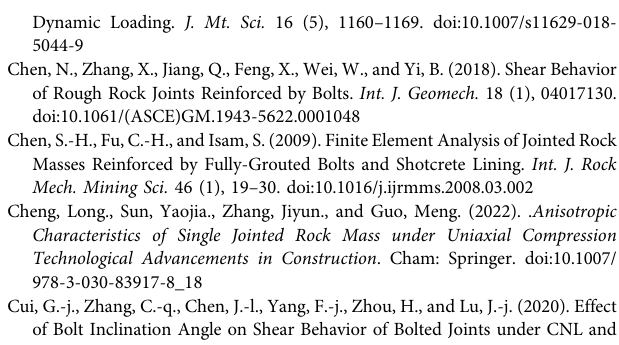
Supplementary Table S1 | Mechanical parameters of the actual rock and mortar Supplementary Table S2 | Mechanical parameters of the prototype rock and simulated bolts Supplementary Table S3 | UCS and the peak strain of jointed and bolted jointed specimens Supplementary Table S4 | Angle of the maximum principle strain direction of jointed and bolted jointed specimens Supplementary Table S5 | Material properties of the specimen used for numerical simulation Supplementary Table S6 | UCS of bolted jointed specimens under different bolt installation